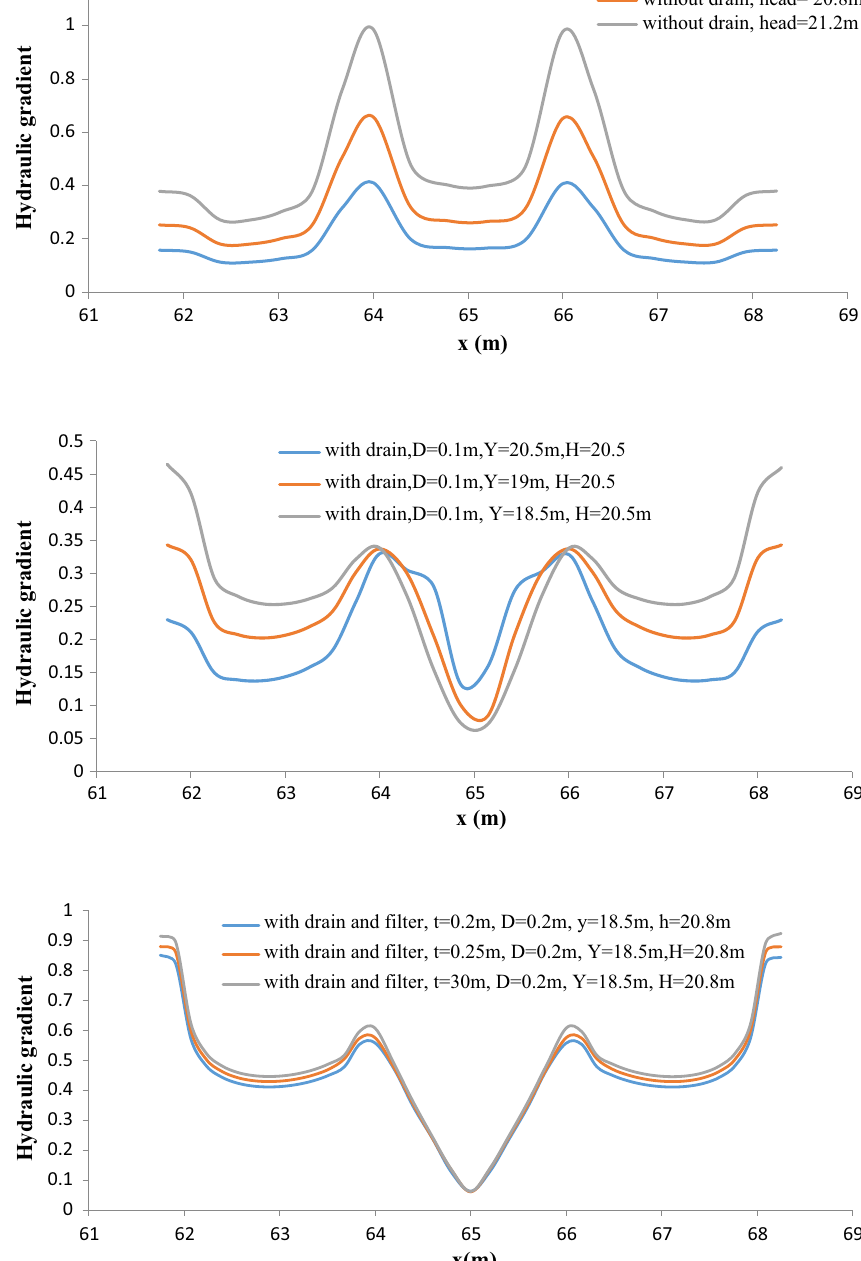
Fig. 11 Gradient for different filter thicknesses around drain with D = 0.2 m, Y = 18.5 m, H = 20.8 m